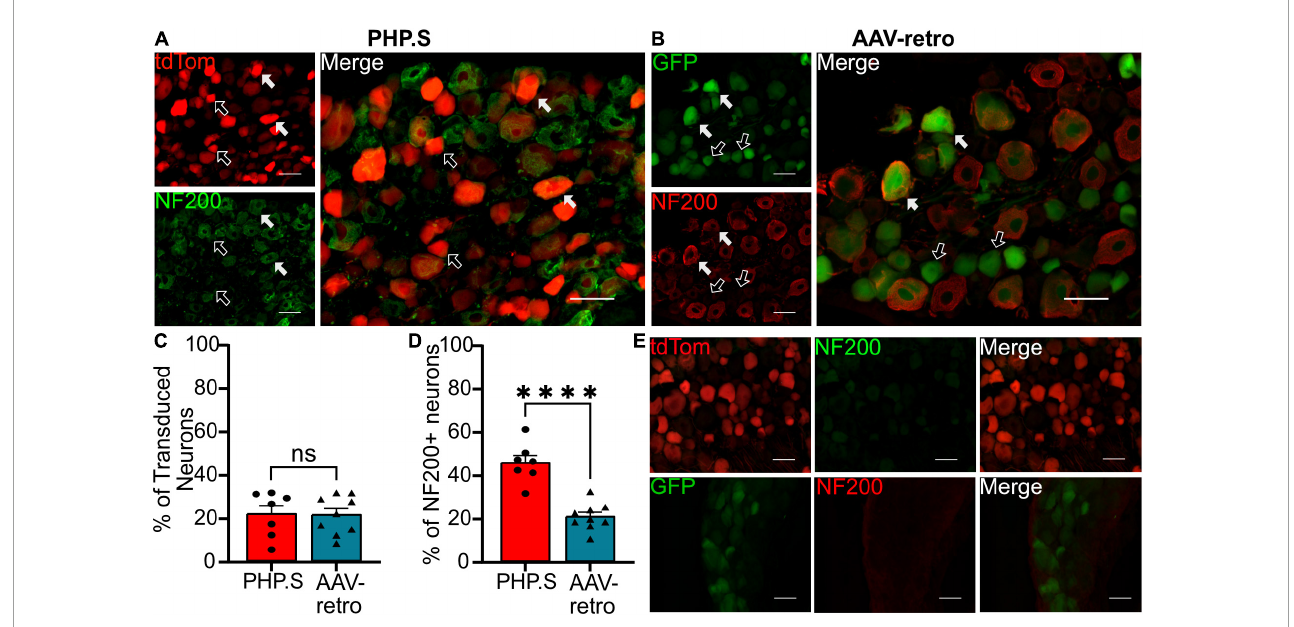
FIGURE6 PHP.S and adeno-associated viruses (AAV)-retro transduce large, myelinated neurons at similar rates. (A) Representative images of tdTomato expression colocalizing with NF200 + neurons in dorsal root ganglia from PHP.S-injected rats (scale bar, 50 µ m). (B) Representative images of GFP expression colocalizing with NF200 + neurons in dorsal root ganglia from AAV-retro-injected rats (scale bar, 50 µ m). (C) Percent of transduced neurons that were NF200 + ( p = 0.9373). (D) Percent of NF200 + neurons transduced by virus ( ∗∗∗∗ p < 0.0001). (E) Images of dorsal root ganglia from rats injected with PHP.S (top) or AAV-retro (bottom) stained with secondary antibody only for the corresponding fluorophore used for NF200 in experimental tissue. Statistics were performed using the student’s t -test to compare PHP.S ( n = 7) to AAV-retro ( n = 9). White arrows indicate neurons with colocalization; black arrows with a white outline indicate viral transduced without